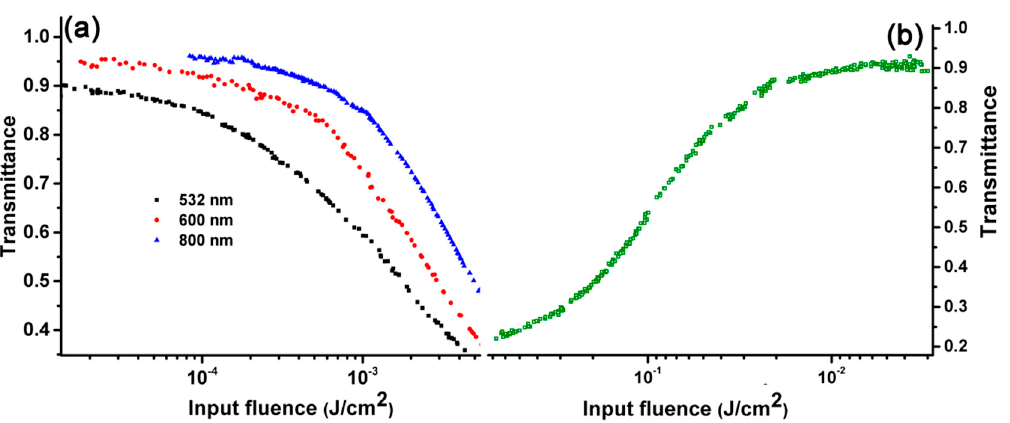
Figure 7. ( a ) Optical limiting behavior of PyDN under selected wavelength with a 190 fs pulse; ( b ) optical limiting behavior under 532 nm with a 15 ps pulse.